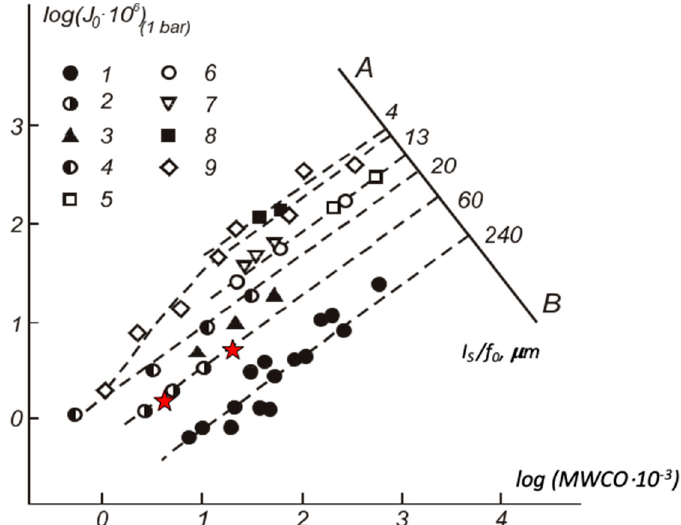
Figure 10. Classification diagram of ultrafiltration membranes [37]: 1, Sartorius SM 115–117, and Vladipore UAM, 2, Biopore A2–10, 3, DDS-5,600, –800, 4, Diaflo UM, 5, Biopore A-20-500, 6, Diaflo XM, 7, Dorr-Oliver XP, 8, Diaflo PM, 9, Gelman Omega. Red stars represent the data obtained for co-PAA (right) and co-PBOI (left) membranes.